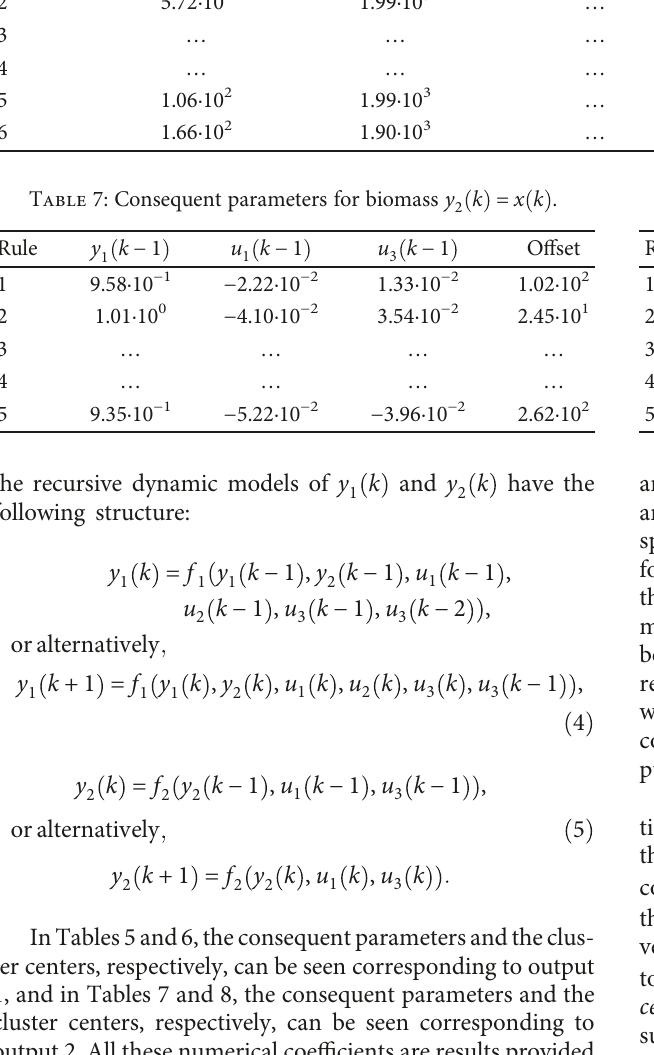
Table 5: Consequent parameters for substrate y